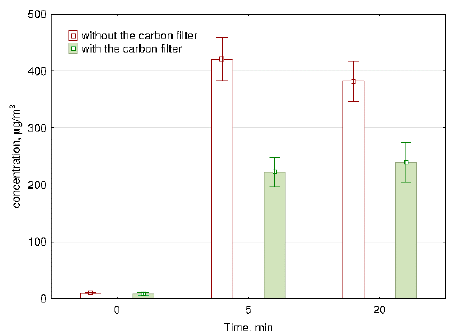
Figure 4. The concentration of ozone during the work of air purifiers with and without carbon filter. The data represent the average values and the standard deviations of six measurements.